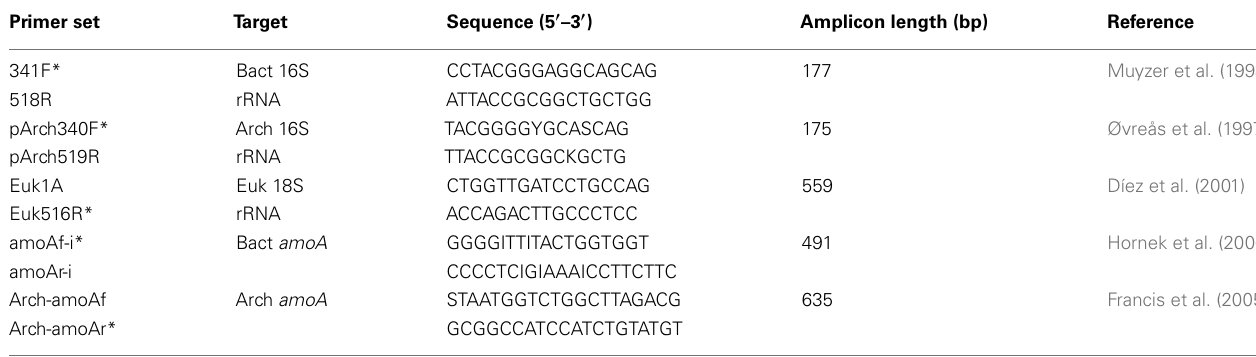
Table 1 | PCR primers used in this